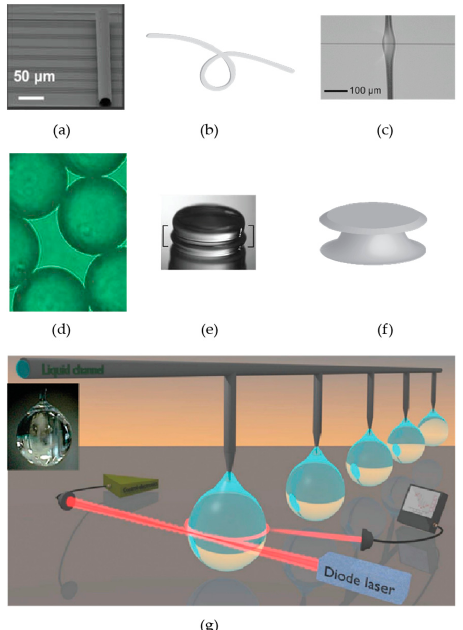
Figure 3. Some examples of different optical microcavities. ( a ) Vertical optical ring resonators. Adapted from [46]; ( b ) Knot resonators; ( c ) Microbubble resonators. Reprinted from [47], with the permission of AIP Publishing; ( d ) Polystyrene microsphere resonators. These resonators